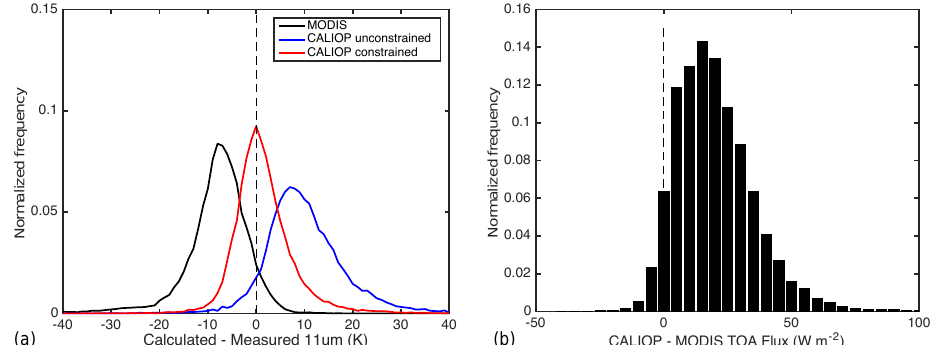
Figure 2. This figure presents the radiative closure results (a) for 1 month (January 2010) of collocated single-layer ice cloud observations using LBLRTM and DISORT to calculate the TOA 11µm radiance that are compared to MODIS channel 31 observations. The only difference in the calculations is the IOT retrieval method. The differences in TOA fluxes resulting from using the MODIS or CALIOP daytime IOT retrievals in the calculation are presented in the right histogram (b)